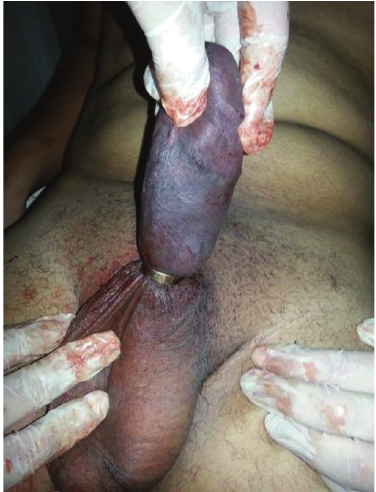
Figure 1: Inside the operative theatre, severe penile edema and color change due to the tight metallic ring at the base of the penis.